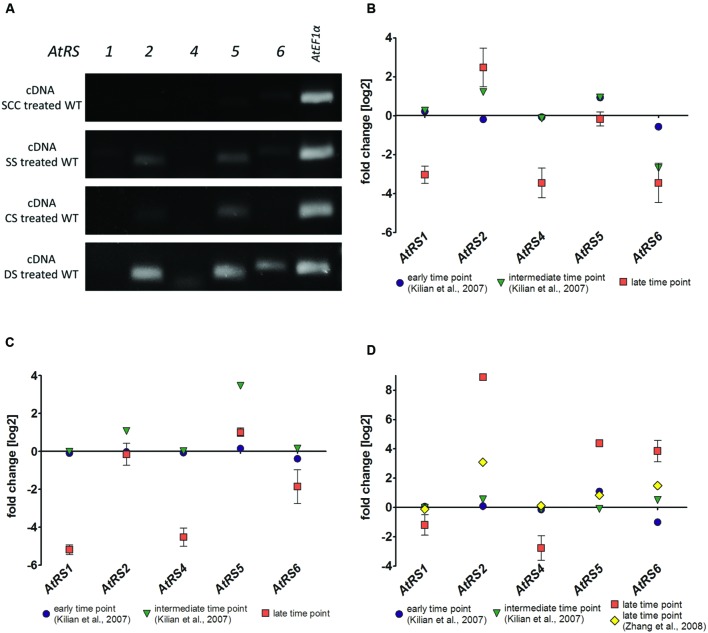
sqPCR, qPCR and gene expression analysis of WT plants after different stress treatments. (A) sqPCR of AtRS1, AtRS2, AtRS4, AtRS5, AtRS6, and AtEF1α was performed with reverse transcribed cDNA from WT leaves after SCC and different stress [including salt stress (SS), cold stress (CS) and drought stress (DS)] treatments. qPCR of AtRS1, AtRS2, AtRS4, AtRS5, AtRS6, AtEF1α was preformed and AtRS gene expressions were analyzed with Genevestigator (Hruz et al., 2008). The log2 fold change values are depicted after (B) salt, (C) cold, and (D) drought stress treatment. Gene expression data points are derived from microarray data from AtGenExpress (Schmid et al., 2005; Kilian et al., 2007) [early (up to 1 h) and intermediate (up to 24 h) time point from SS time course; early and intermediate time point from CS time course; early and intermediate time point from DS time course] and from Zhang et al. (2008) [late (up to 11 days) time points from DS] as verification. qPCR data points are generated from (B) 100 mM NaCl for 14 days (late time point) SS treated WT leaves, from (C) at 4°C for 14 days (late time point) CS treated leaves and from (D) DS treated leaves by withdrawing water for 7 (late time point) days.